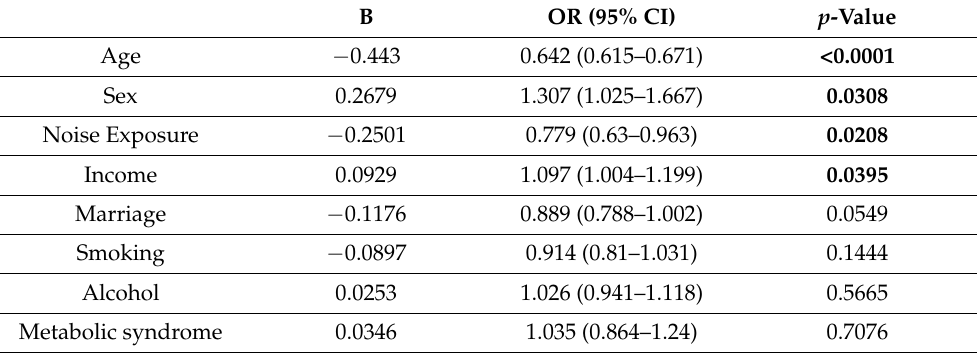
Table 2. Multiple regression models including factors affects hearing impairment.